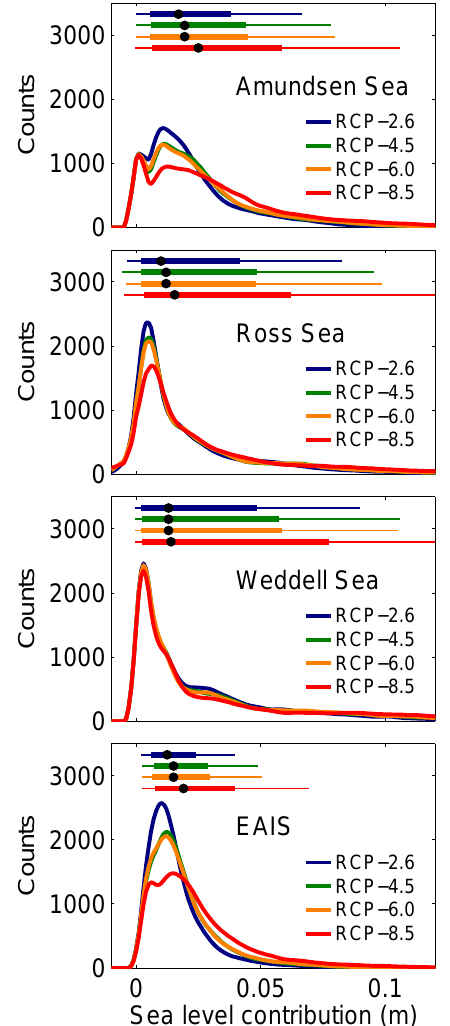
Figure 9. Probability density function for the sea-level contribution from basal-melt-induced ice discharge for each region for the year 2100. Different colours represent the four RCP scenarios. Thick horizontal lines at the top of each panel provide the 66% range of the distribution, the black dot is the median and the thin line the estimate of the 90% range. Amundsen has the highest median contributions though sectors are relatively similar. Scenario depen- dency is strongest for the Amundsen region and East Antarctica. The distributions are highly skewed towards higher sea-level con- tributions. Results are shown for the models with explicit ice-shelf representation